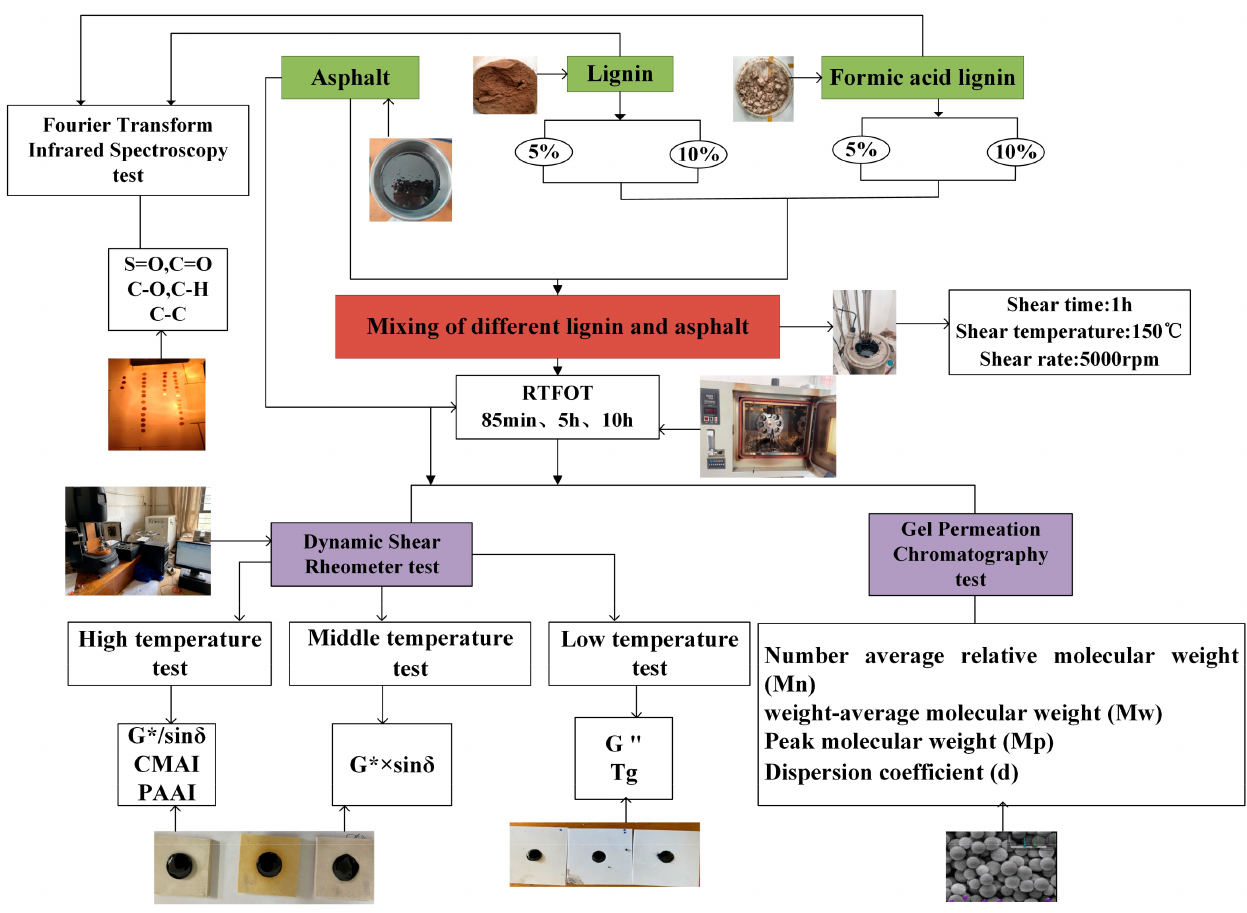
Figure 1. Experimental plan of the